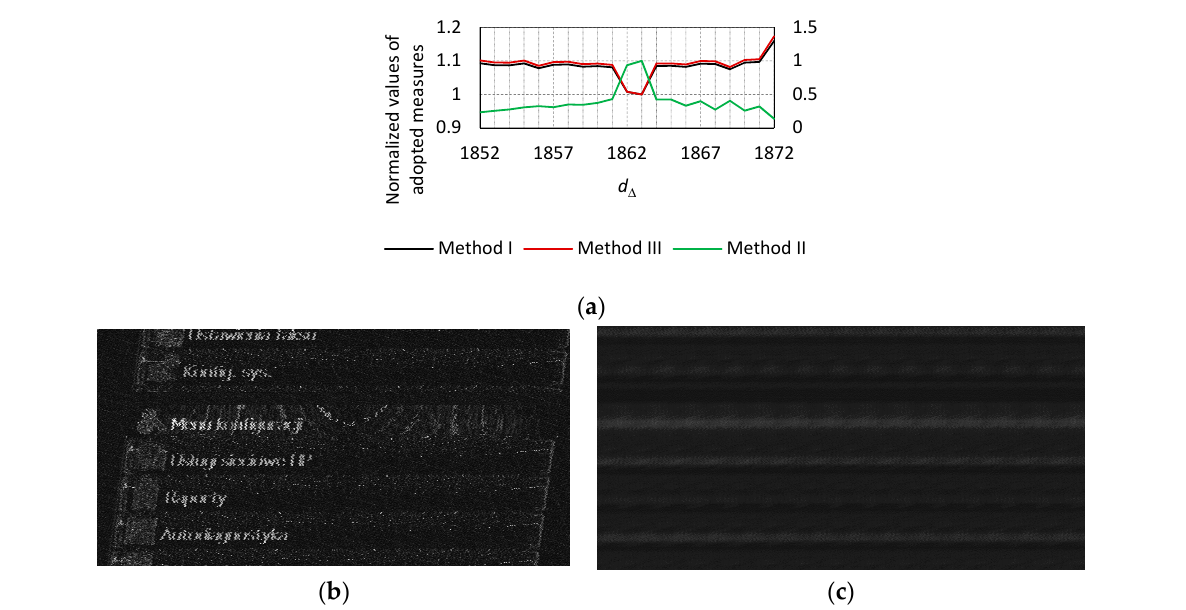
Figure 33. ( a ) The normalized values of the adopted measures (method I, II and III) calculated in domain of image line length d ∆ for the accuracy ∆ = 1.0 (for the original image shown in Figure 7f) and images reconstructed on the basis of the recorded revealing emission signals at frequency f o = 235 MHz (receiving bandwidth BW = 10 MHz, accuracy ∆ = 1.0), ( b ) for estimated line length d ∆ = 1863.00000, image summation multiple Sum MTL = 1 and ( c ) for estimated line length d ∆ = 1863.00000, multiple of image summation Sum MTL = 60 —the source of revealing signal emission—display of laser printer.